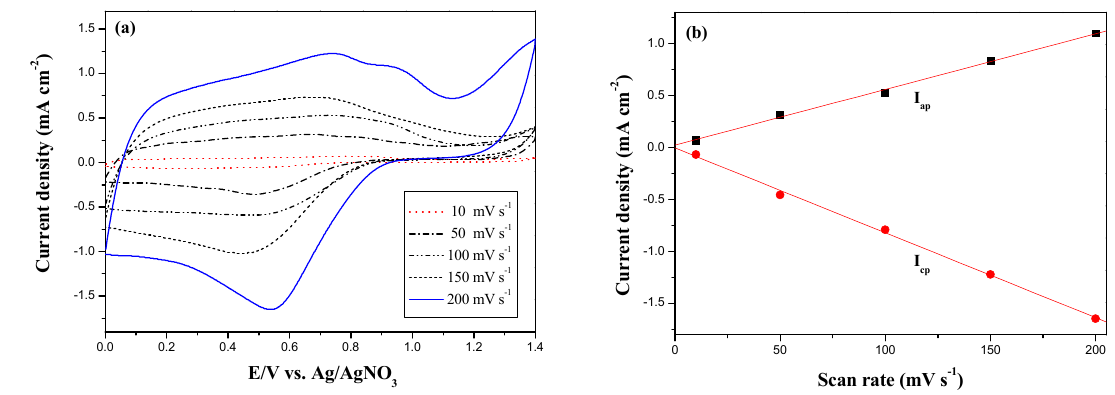
Figure 5. ( a ) CV curves of the P(Inc- co -bT) film at different scan rates between 10 and 200 mV s − 1 in PC+ACN solution containing 0.2 M LiClO 4 ; ( b ) Scan rate dependence of the anodic and cathodic peak current densities of P(Inc- co -bT) film.